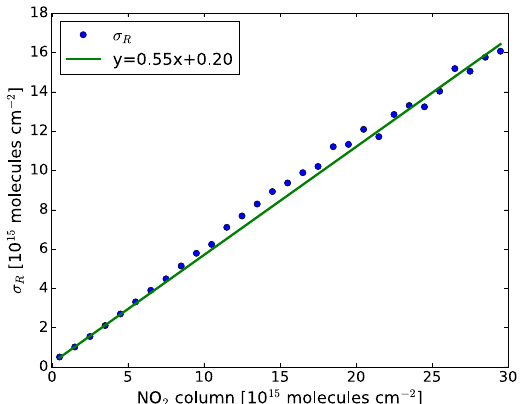
Figure 1. The relation between σ R and the average of the observed and modelled NO 2 column. The green line is the fit